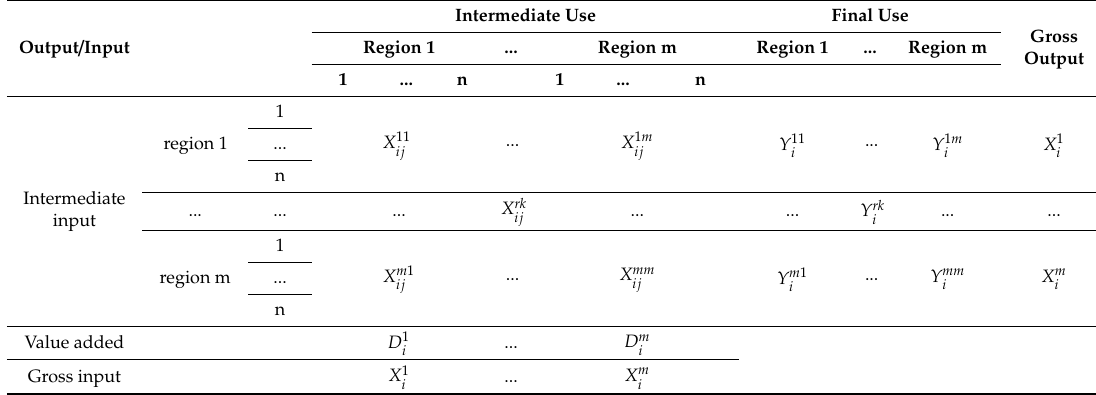
Table 1. Basic form of the multi-regional input-output (MRIO)